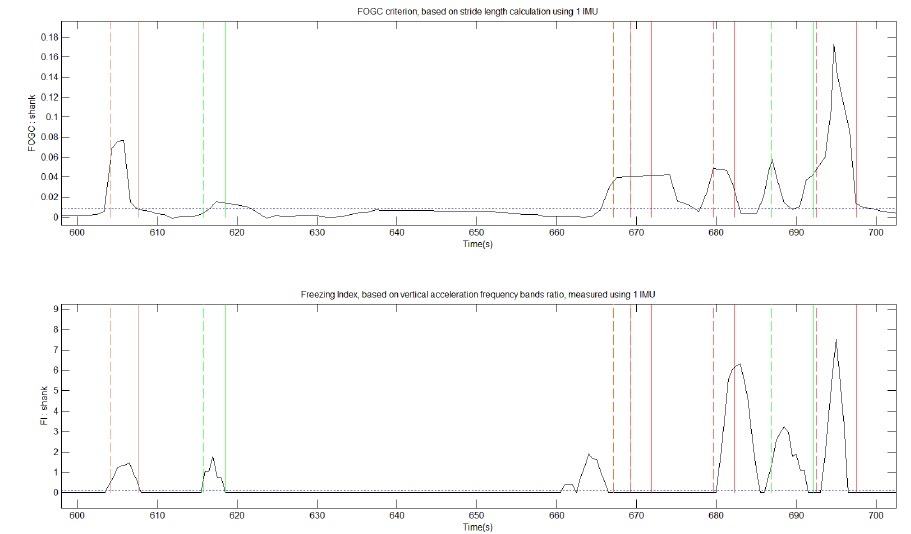
Figure 4. Zoomed view of Figure 3. Around 670 s, an important FOG event is detected by FOGC ( Top ) but not FI ( Bottom ).